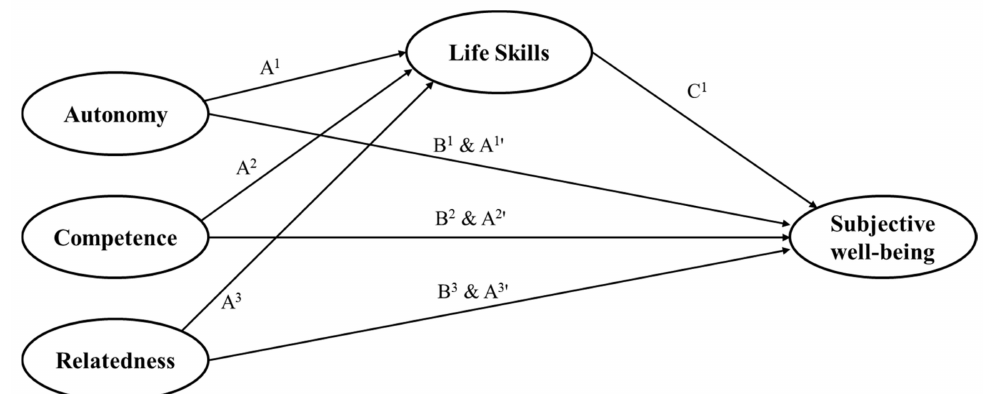
Figure 2. Hypothesized model of relations among basic psychological needs, life skills, and subjective well-being. Note: A 1 –A 3 paths represent the relationship between three basic needs (autonomy, com- petence, and relatedness) and life skills; B 1 –B 3 paths represent the relationship between three basic needs and SW; C 1 path represents the relationship between life skills and SW; A 1 ’–A 3 ’ paths represent the mediation effect of life skills between three basic needs and SW; SW refers subjective well-being.